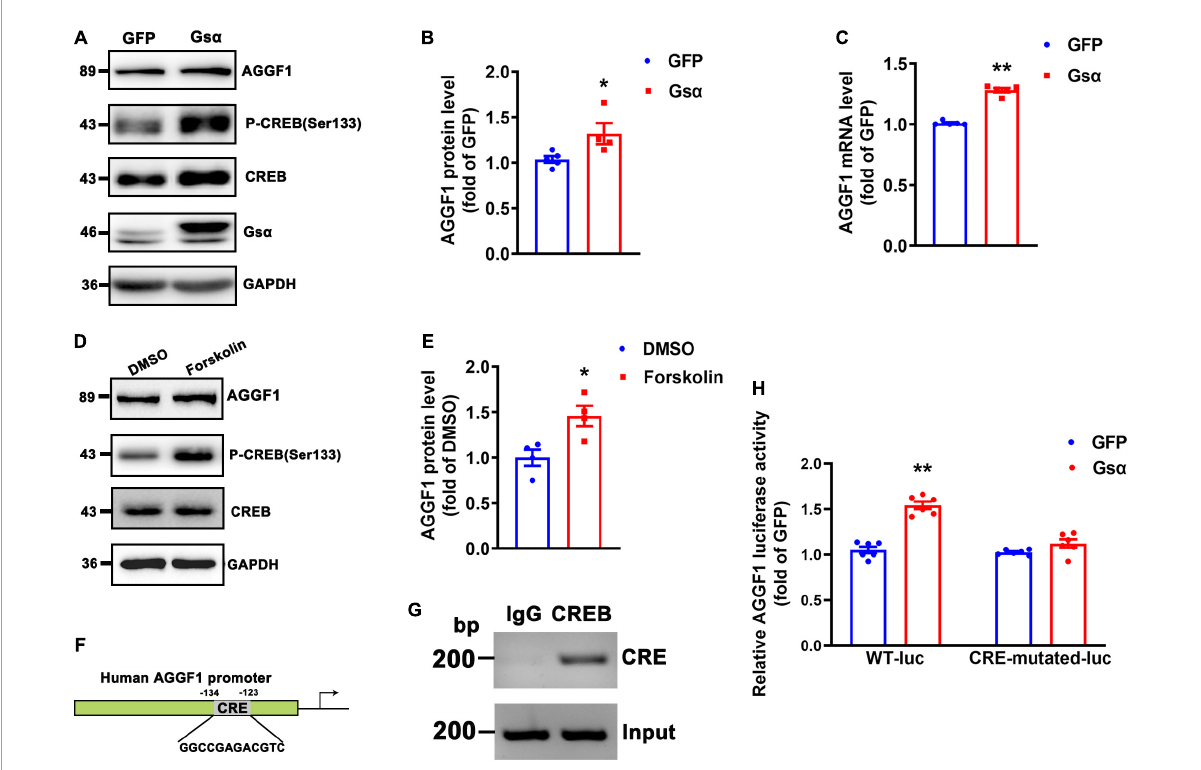
FIGURE5 Gs α regulates AGGF1 expression via CREB in endothelial cells. (A,B) Western blot analysis and quantification of AGGF1 in HUVECs infected with adenovirus-expressing GFP or Gs α . n = 5 for GFP; n = 4 for Gs α , * P < 0.05 vs. GFP (unpaired Student’s t -test). (C) RT-qPCR analysis of AGGF1 mRNA in HUVECs infected with adenovirus-expressing GFP or Gs α . n = 5/group, ** P < 0.01 vs. GFP (unpaired Student’s t -test). (D,E) Western blot analysis and quantification of AGGF1 in HUVECs treated with forskolin (10 µ M) for 24 h. n = 4/group, * P < 0.05 vs. DMSO (unpaired Student’s t -test). (F) Predicted CRE site in the human AGGF1 promoter. (G) Binding of CREB to the CRE of the AGGF1 promoter was shown by Chromosome immunoprecipitation assay. (H) Luciferase activity in HEK-293T cells transfected with wild-type or a mutant AGGF1 promoter-luciferase construct and infected with adenovirus-expressing GFP or Gs α for 24 h. Results of luciferase promoter assay were firefly/Renilla luciferase activity, n = 6/group, ** P < 0.01 vs. GFP (One-Way ANOVA and Bonferroni post-tests). Data are mean ± SEM.